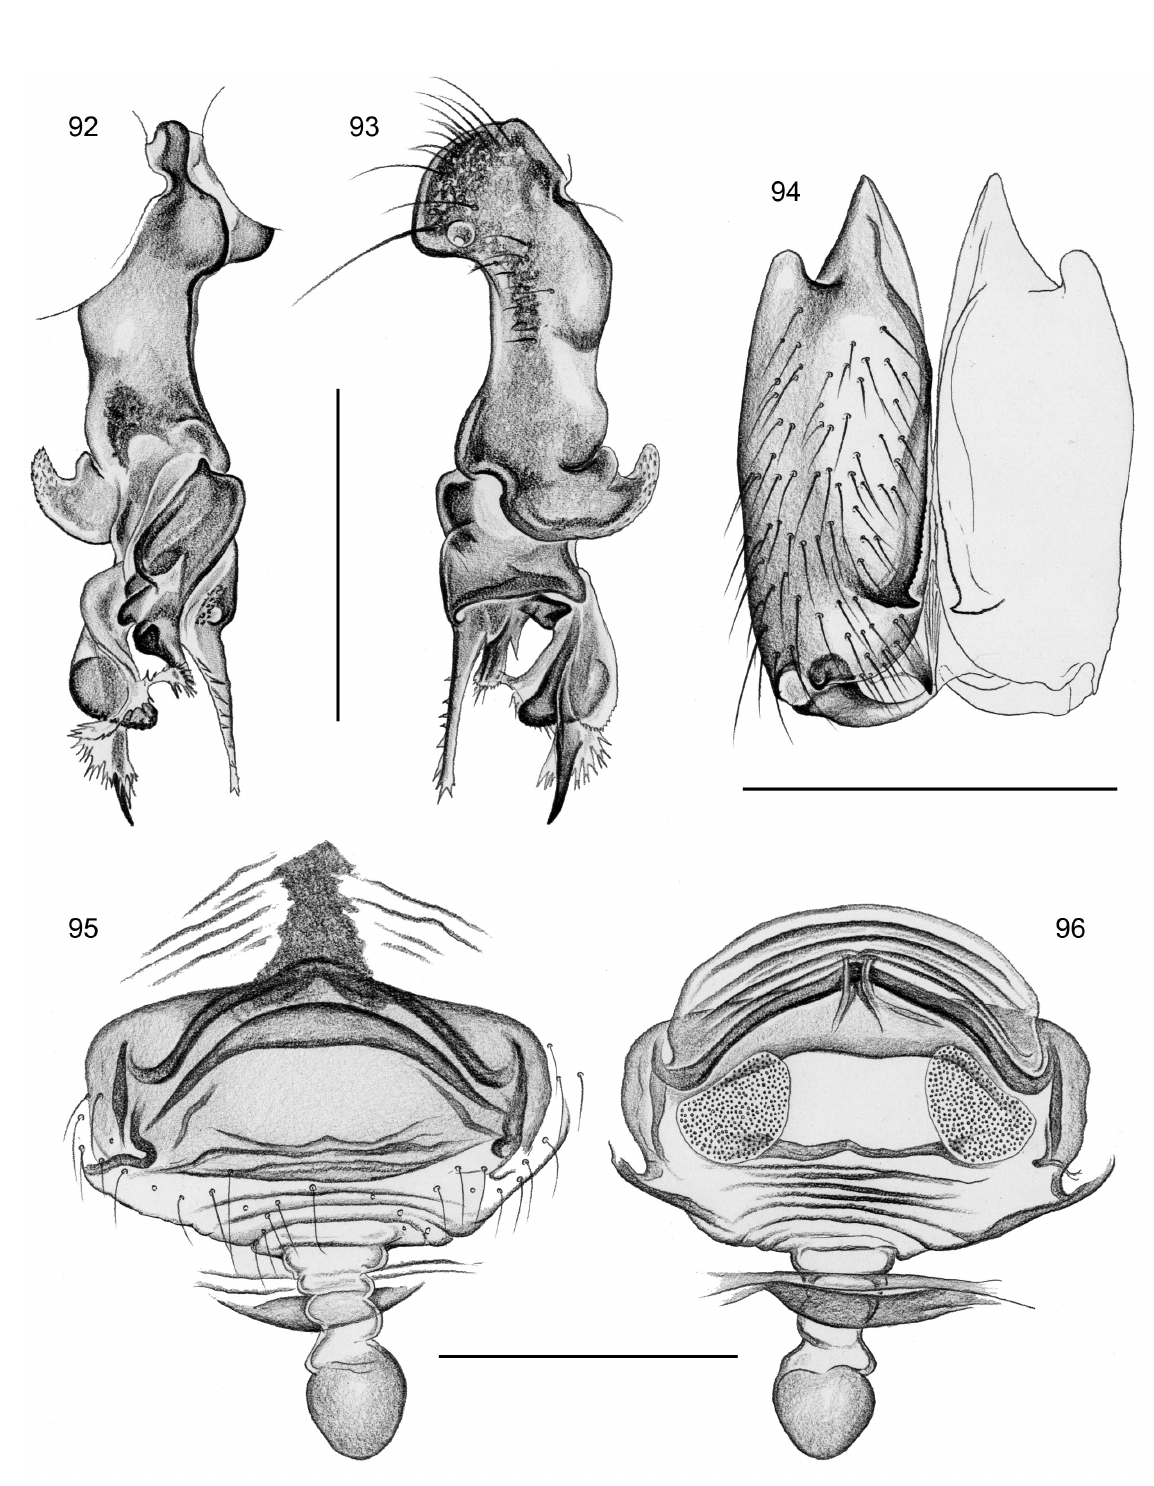
Figs 92-96. Spermophora maathaiae sp. nov. 92-93. Left ♂ procursus, prolateral and retrolateral views. 94. ♂ chelicerae, frontal view. 95-96. ♀ genitalia, ventral and cleared dorsal views. Scale lines: 0.5 mm.